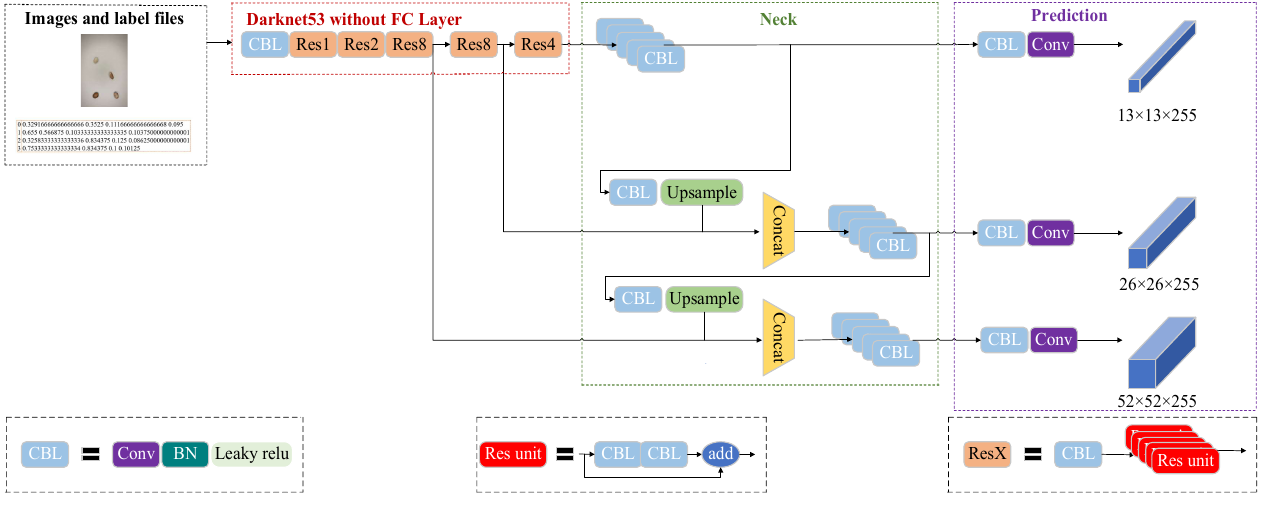
Figure 4. The structure of the Yolov3 network.